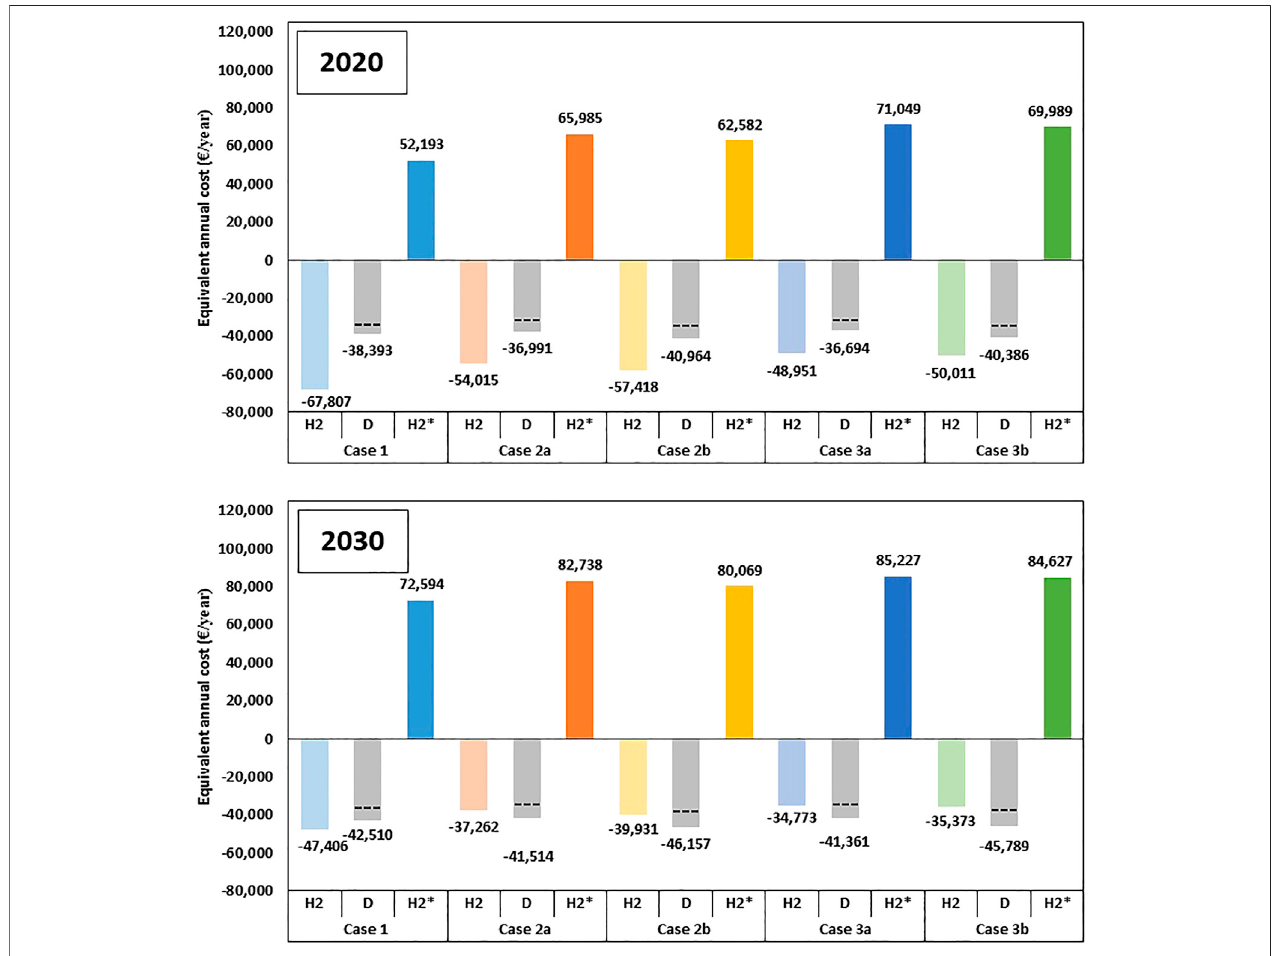
FIGURE 8 | Equivalent annual cost (EAC) of the different cases assessed. Note: H2 means PtH 2 without land lease revenues; D means diesel-fueled farm; H2* means PtH 2 with land lease revenues; Values are presented per farm in Cases 2a,b, and 3a,b; black dotted lines represent EAC of diesel with tax relief; EAC values of PtH 2 cases do not consider waste heat (WH) or O 2